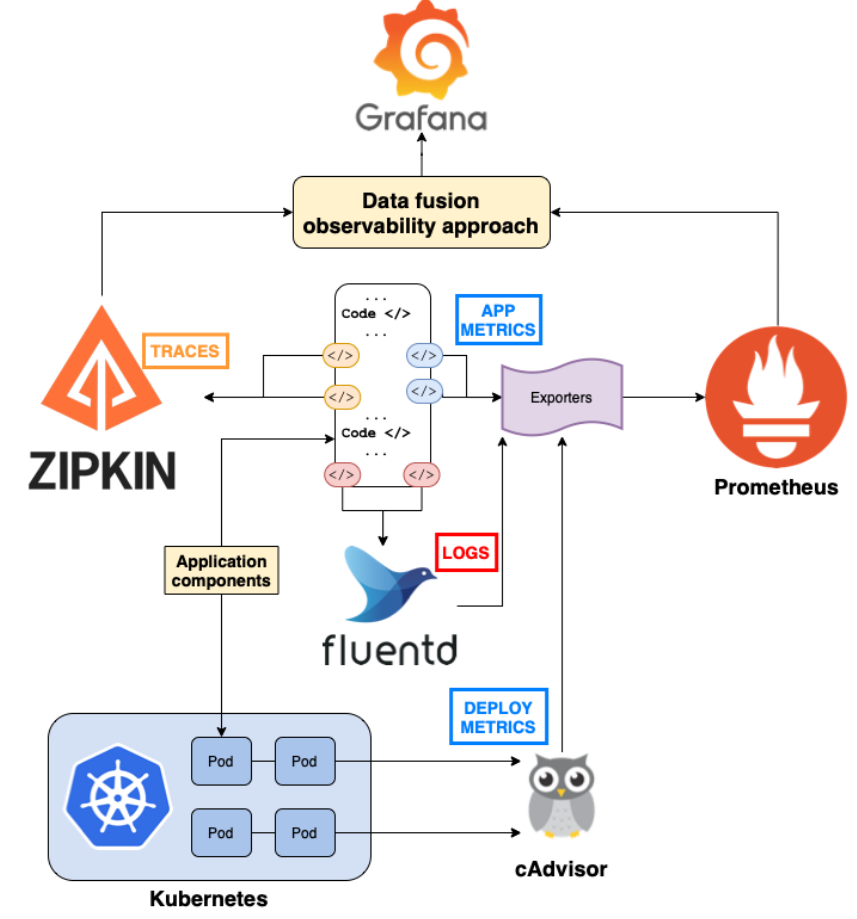
Figure 5. Instrumentation